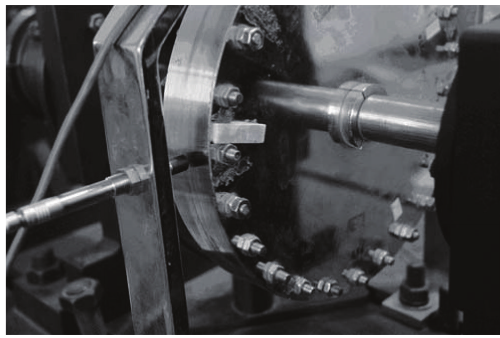
Figure 13: Simulation of blade-out event.